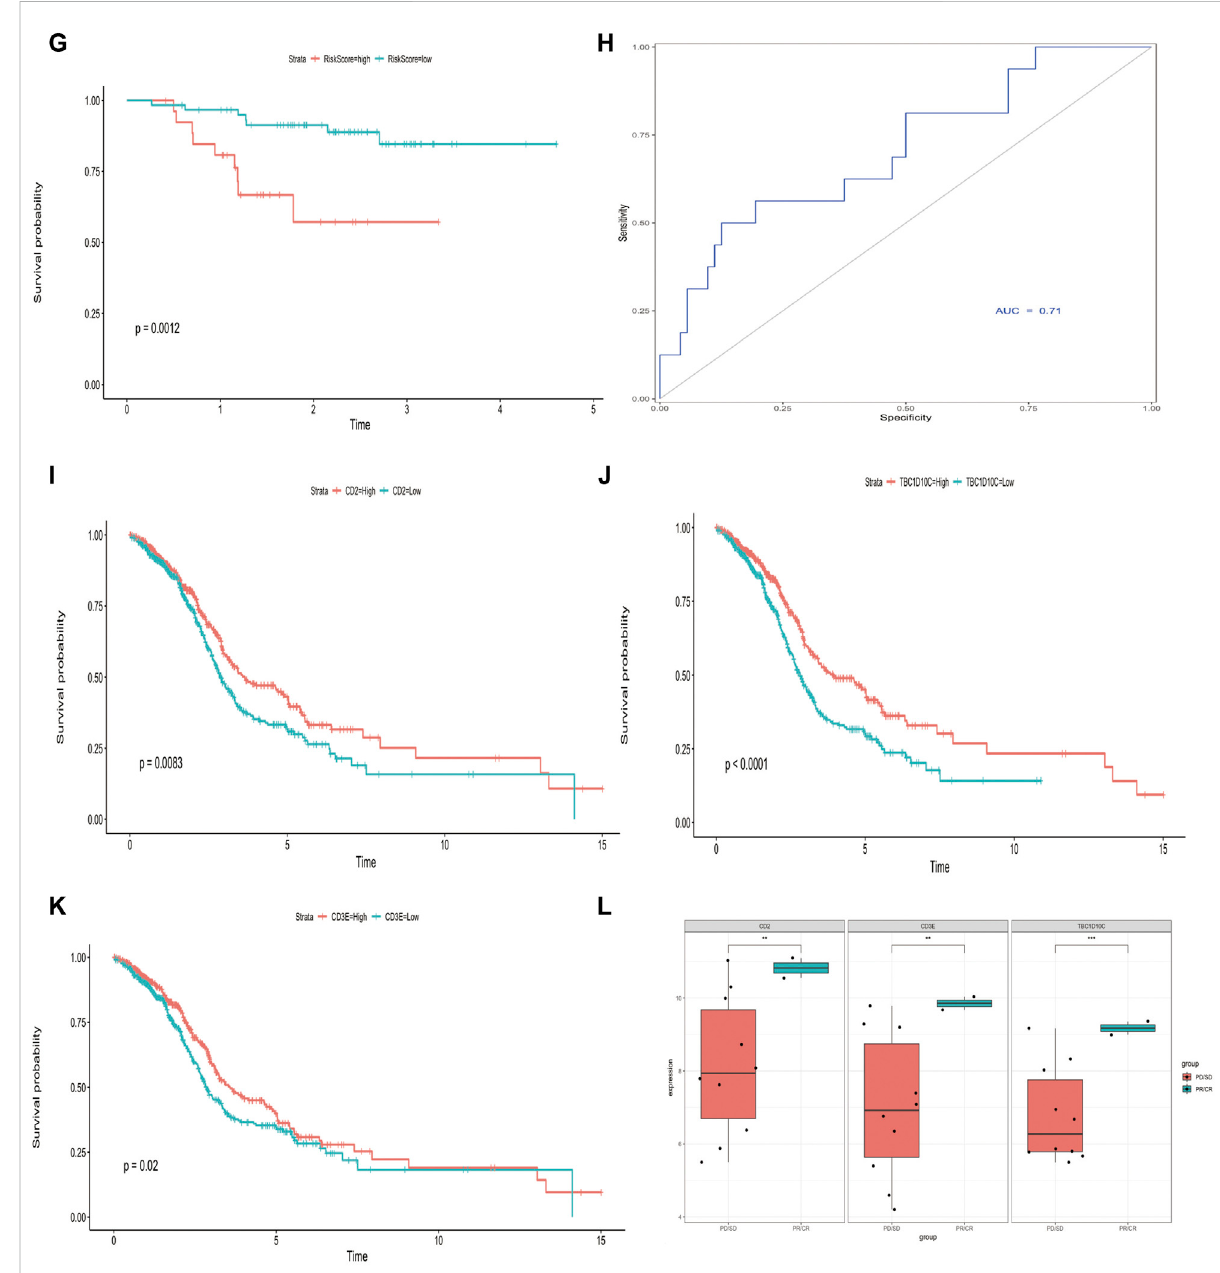
FIGURE 6 Construction and veri fi cation of IMS risk prediction model. (A) Hundred-time cross-validation for tuning parameter selection in the LASSO model; combined cohort. (B) Risk score range in two groups (0 = alive, 1 = dead); combined cohort. (C) Kaplan – Meier curve shows high-risk and low-riskgroupsbasedontheriskscore;combinedcohort;logrank p < 0.0001;unitoftime(years). (D) Kaplan – Meiercurveshowshigh-riskandlow- risk groups based on the risk score; TCGA cohort; log rank p = 0.00054, unit of time (years). (E) Receiver operating characteristic curve in combined cohort; AUC = 0.58. (F) Time – ROC curve in combined cohort; AUC 1 year = 0.58; AUC 3 years = 0.55; AUC 5 years = 0.59. (G) Kaplan – Meier curve shows high-risk and low-risk groups based on the risk score; external GSE102349 cohort; log rank p = 0.0012; unit of time (years). (H) ReceiveroperatingcharacteristiccurveinGSE102349cohort;AUC=0.71. (I – K) Kaplan – Meiercurveshowshigh-riskandlow-riskgroups basedonCD2,TBC1D10C,andCD3Eexpression,respectively;combinedcohortCD2logrank p =0.0083;TBC1D10Clogrank p < 0.0001;CD3Elog rank p = 0.02; unit of time (years). (L) CD2, TBC1D10C, and CD3E expression in immunotherapy cohort, complete response (CR), partial response (PR), stable disease (SD), progressive disease (PD) as per RECIST criteria; asterisks represent different p values (* < 0.05; ** < 0.01; *** < 0.001, **** <